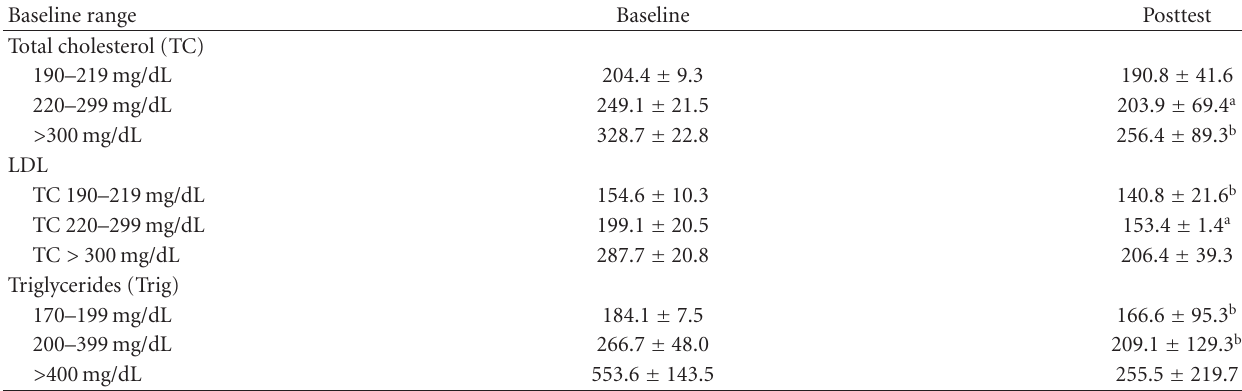
Table 2: Total cholesterol (TC), LDL, and triglyceride levels within specified baseline ranges among the aggregate noni juice group (both doses